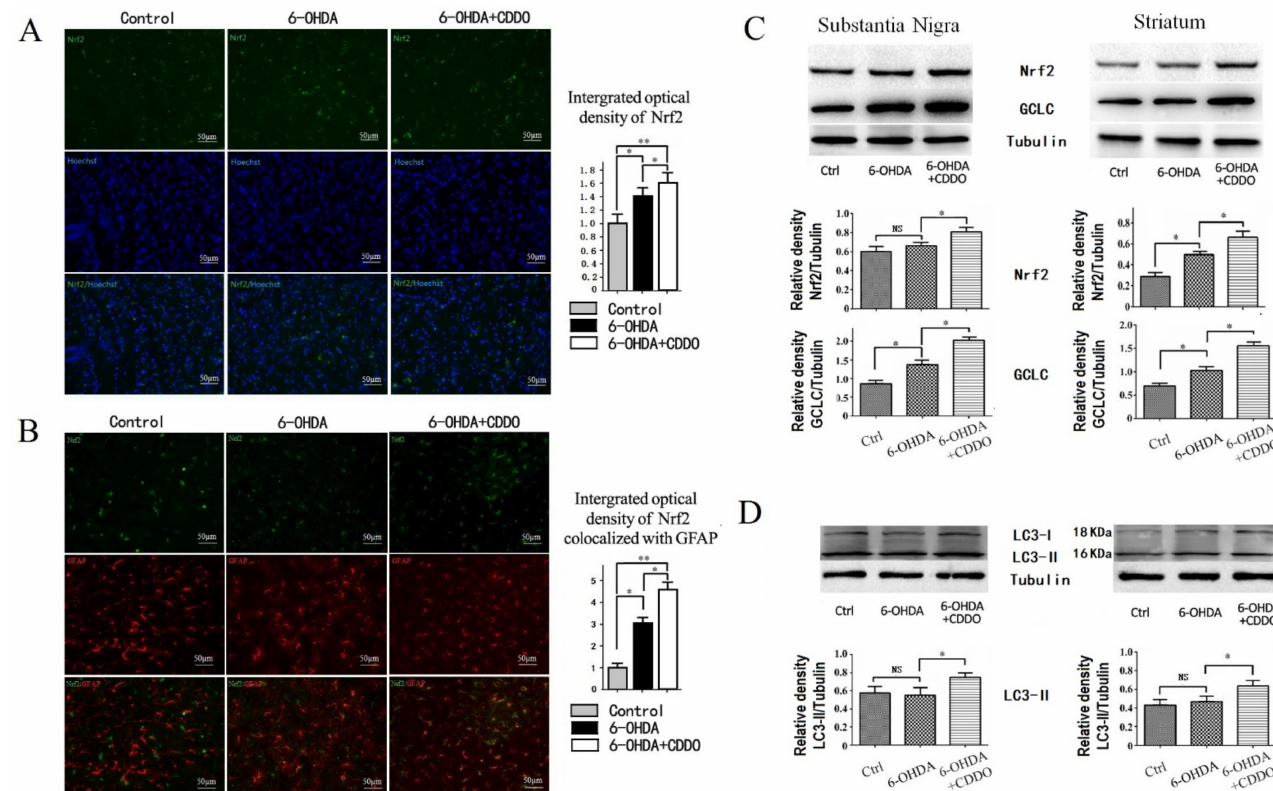
Figure 2. CDDO-Me activated Nrf2/ARE pathway predominantly in astrocytes in 6-OHDA rat brains. ( A ) Nrf2 immunos- taining. Representative pictures show Nrf2 immunofluorescence in SNpc at week 2 after 6-OHDA injection, and nuclei were re-stained with Hoechst (200 × magnification). The bar graph on the right side of the pictures is the quantitative analysis of optical density for fluorescence. The Nrf2-positive cells were few in the control group and mainly distributed in the cytoplasm. The Nrf2 signal increased in the 6-OHDA group compared with the control group (* p < 0.05, n = 5) and was mainly distributed in the nucleus. CDDO-Me increased Nrf2-positive cells in the 6-OHDA + CDDO group compared with the 6-OHDA group and control group (* p < 0.05,** p < 0.01, n = 5), and the Nrf2 signal was also mainly distributed in the nucleus in the 6-OHDA + CDDO group. ( B ) Co-immunostaining of Nrf2 with GFAP. Representative pictures show Nrf2 fluorescence was mainly distributed in neurons but not in GFAP-positive astrocytes in control group. Increased Nrf2 signal was colocalized with GFAP staining in the 6-OHDA group and 6-OHDA + CDDO group. The bar graph on the right side of the pictures is the quantitative analysis of optical density for Nrf2 fluorescence colocalization with GFAP-positive astrocytes. The results show more Nrf2 signal colocalized with GFAP fluorescence in the 6-OHDA group compared with the control group (* p < 0.05, n = 5). CDDO-Me further increased the Nrf2-positive signal in GFAP-positive astrocytes in the 6-OHDA + CDDO group compared with the 6-OHDA group (* p < 0.05, ** p < 0.01, n = 5). ( C ) Representative Western blots of Nrf2 and GCLC proteins in the substantia nigra and striatum homogenate. The bar graph below is the quantitative analysis of Western blot bands. Nrf2 did not significantly change in the substantia nigra (NS p > 0.05) and increased in the striatum in the 6-OHDA group compared with the control group (* p < 0.05). CDDO-Me increased Nrf2 in both substantia nigra and striatum in the 6-OHDA + CDDO group compared with in the 6-OHDA group (* p < 0.05). The Nrf2 downstream antioxidant GCLC also significantly increased in the substantia nigra and striatum in the 6-OHDA group compared with the control group (* p < 0.05). CDDO-Me further increased the GCLC level in the 6-OHDA + CDDO group compared with in the 6-OHDA group (* p < 0.05). ( D ) Representative Western blots of LC3 and quantitative analysis. The expression of the autophagy-related protein LC3-II did not significantly change in the substantia nigra and striatum in the 6-OHDA group compared with the control group (NS p > 0.05). CDDO-Me effectively increased LC3-II expression in the 6-OHDA + CDDO group compared with the 6-OHDA group (* p <